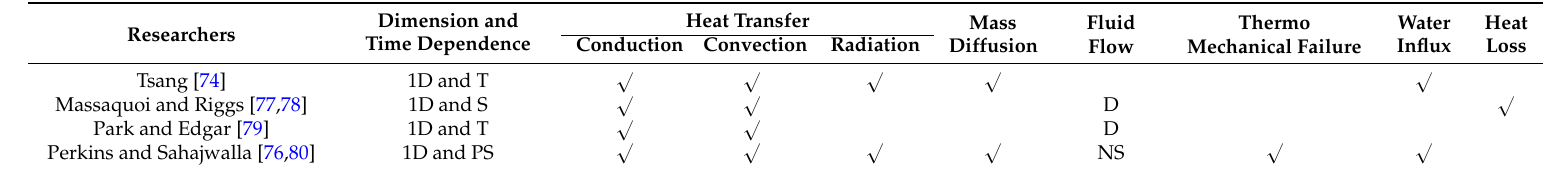
Table 16. Some essential features of reported coal slab models.